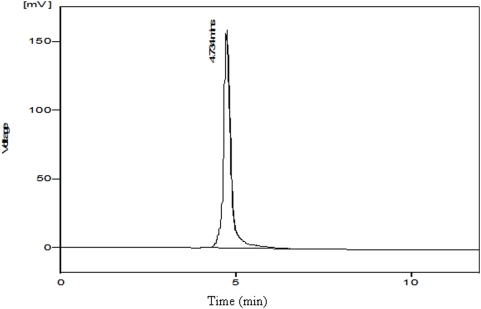
Purity of AECHL-1 as assessed by HPLC.Single peak indicated that the preparation was >99%
pure.